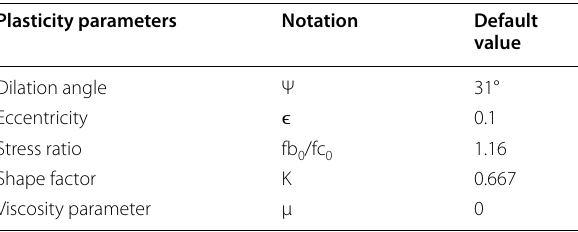
Table 8 CDP Abaqus default